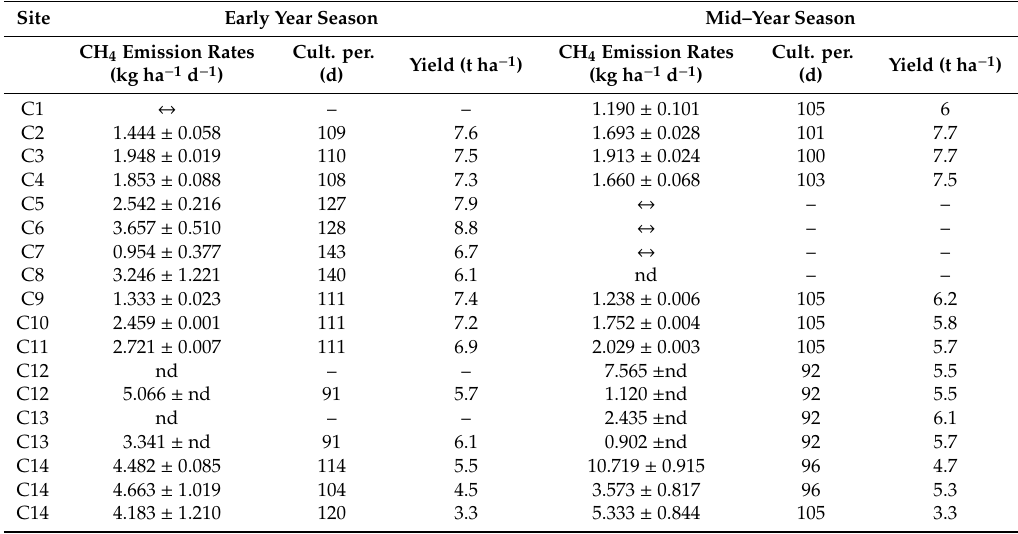
Table 3. Field measurements of daily CH 4 emission rates and cultivation period in South Vietnam.